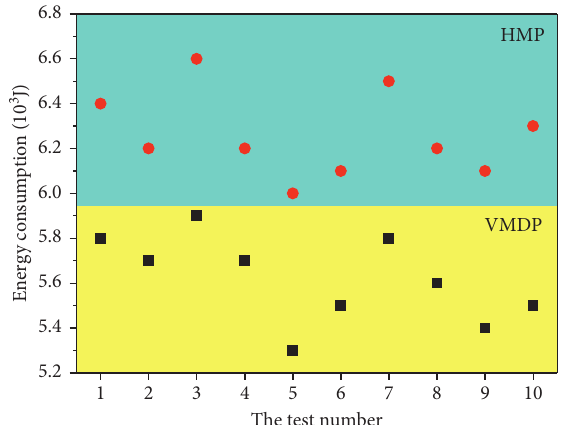
Figure 7: Distribution of average video playback energy consumption after using two different optimization strategies in ten test environments.